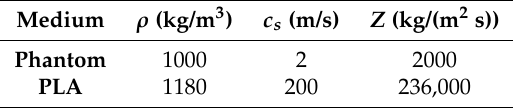
Table 6. Shear impedance for each medium